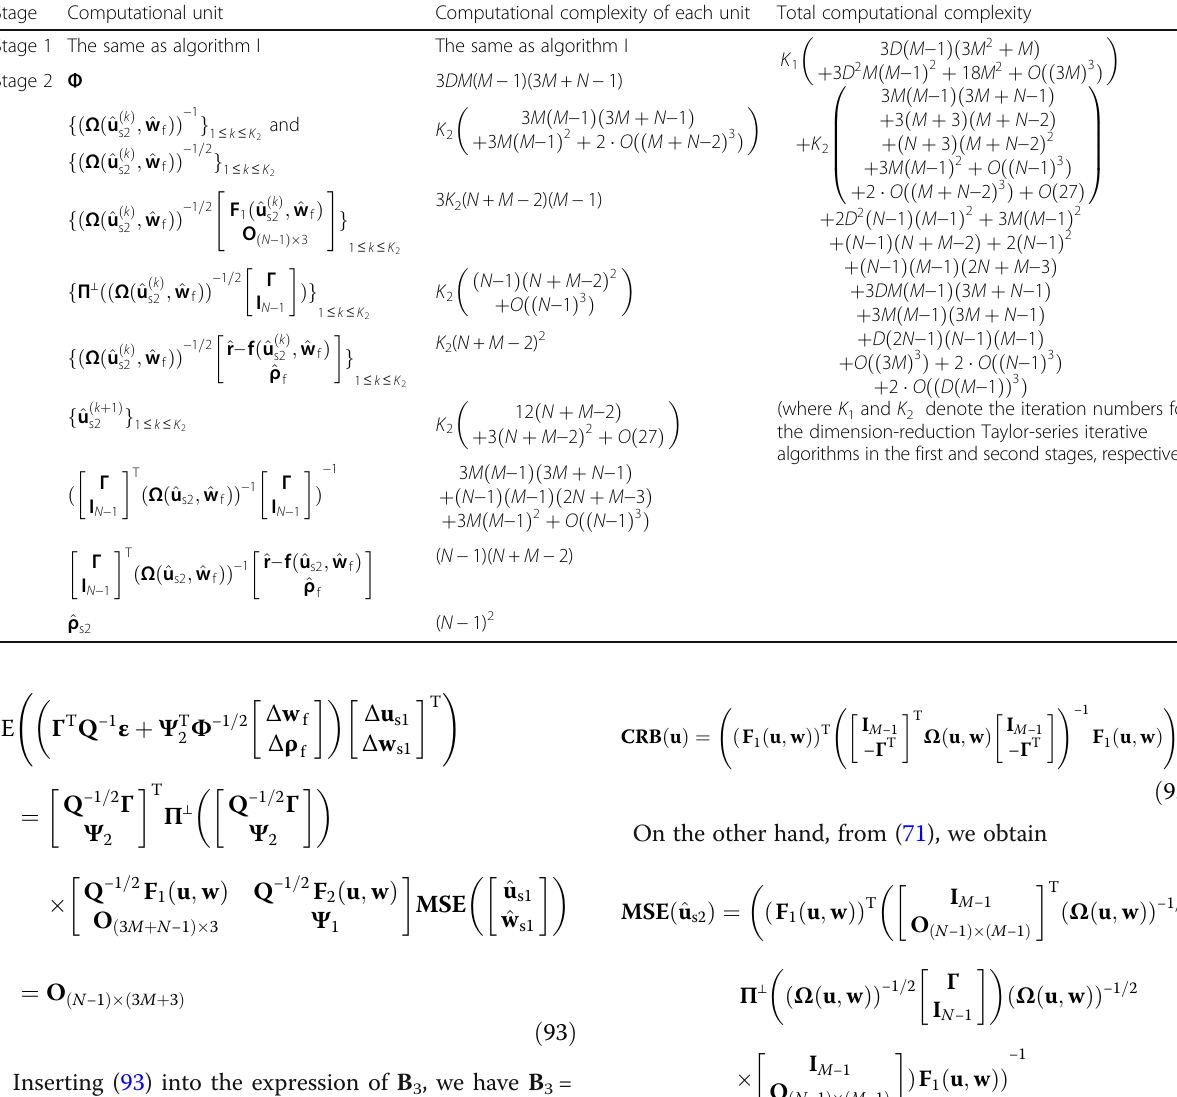
Table 7 Complexity of algorithm II Stage Computational unit Computational complexity of each unit Total computational complexity Stage 1 The same as algorithm I Stage 2